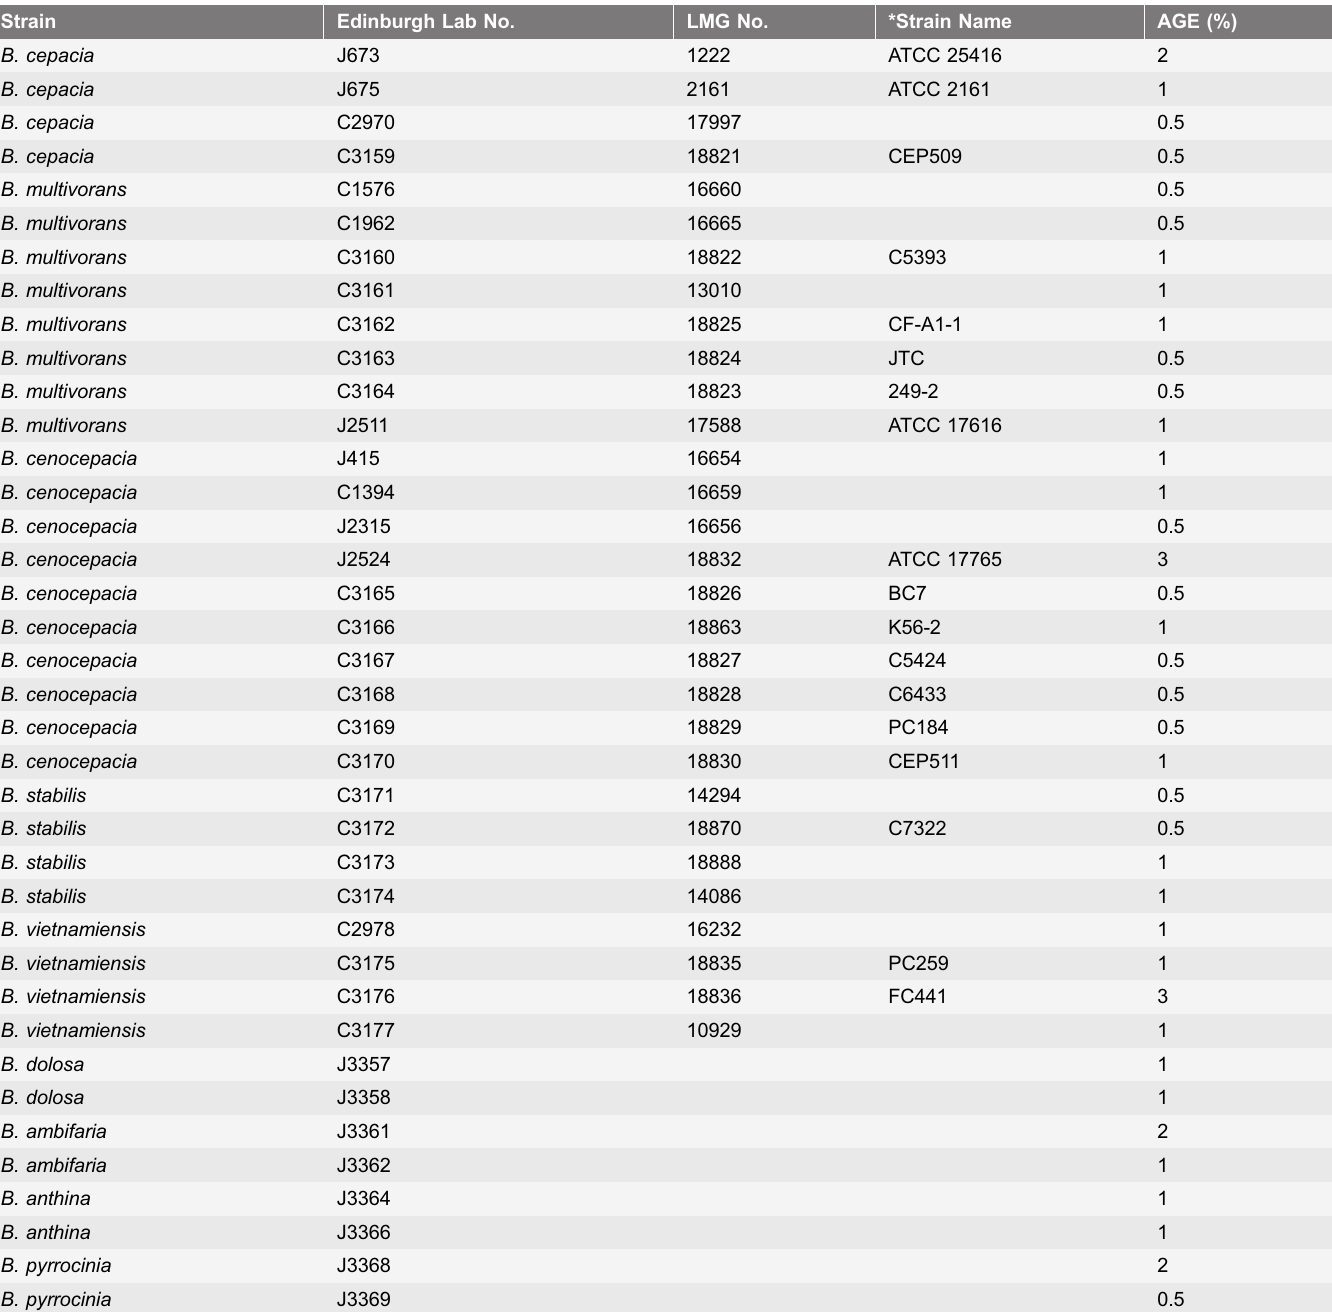
Table 1. MICs ( m g/ml) of AGE for B. cepacia complex.